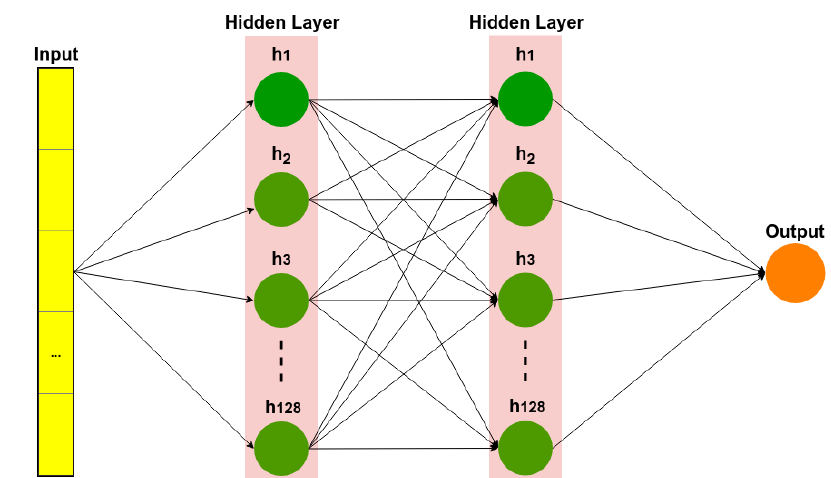
Figure 2. Deep neural network (DNN).